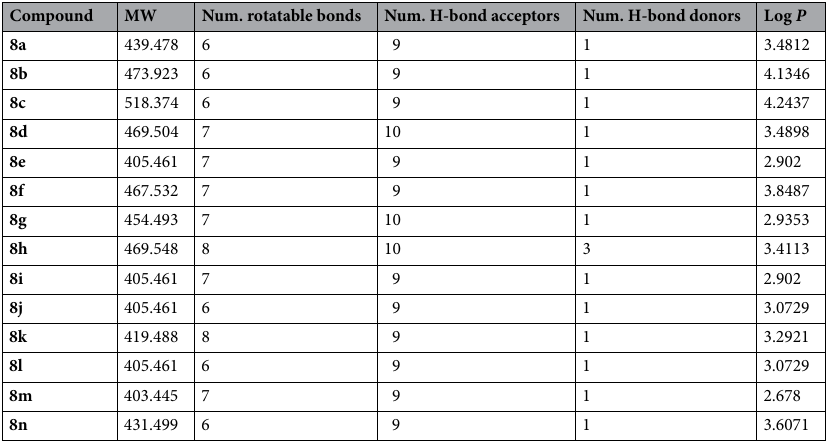
Table 4. Drug-likeness properties of synthesized